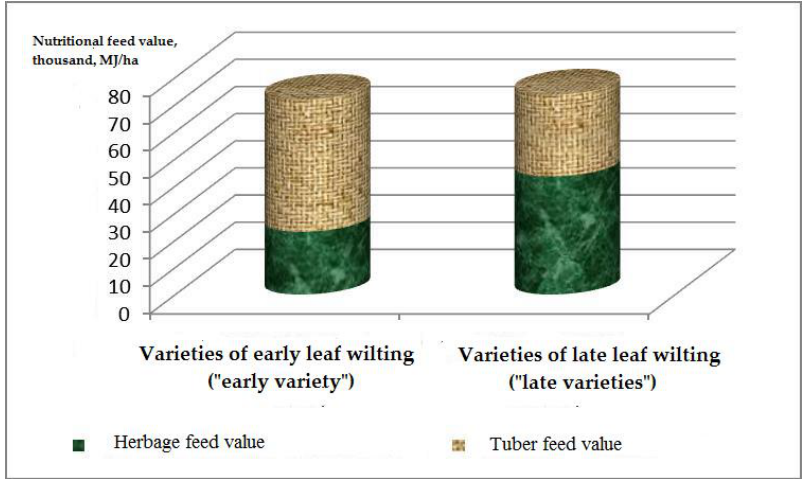
Figure 3. Average feed value of herbage and tubers of Jerusalem artichoke varieties with different leaf wilting periods (average for 2014 – 2016).